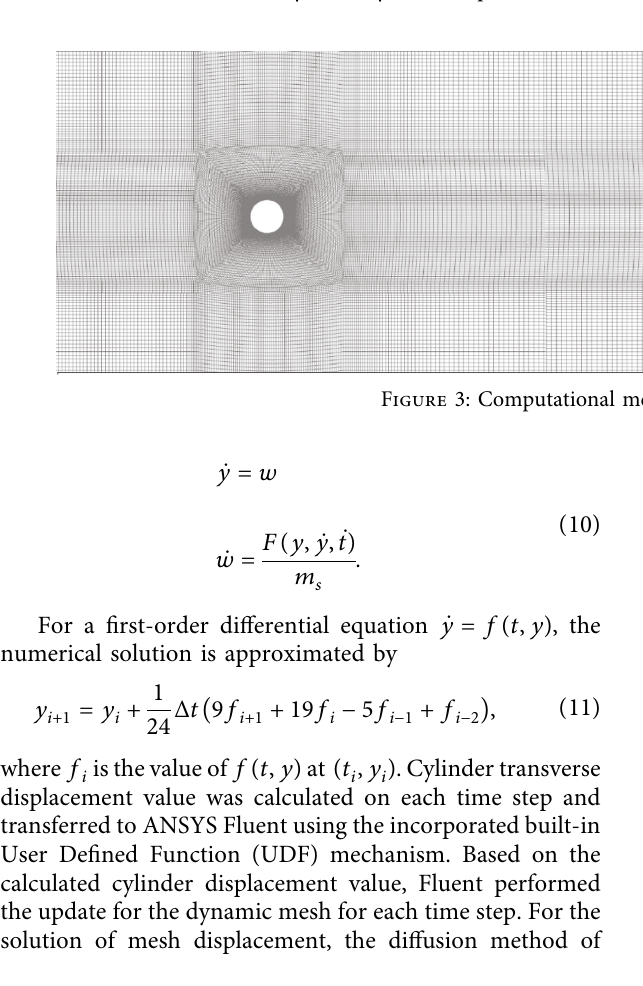
Figure 2: The cylinder dynamic responses (a) and the lift coefficients (b) with different mesh schemes.